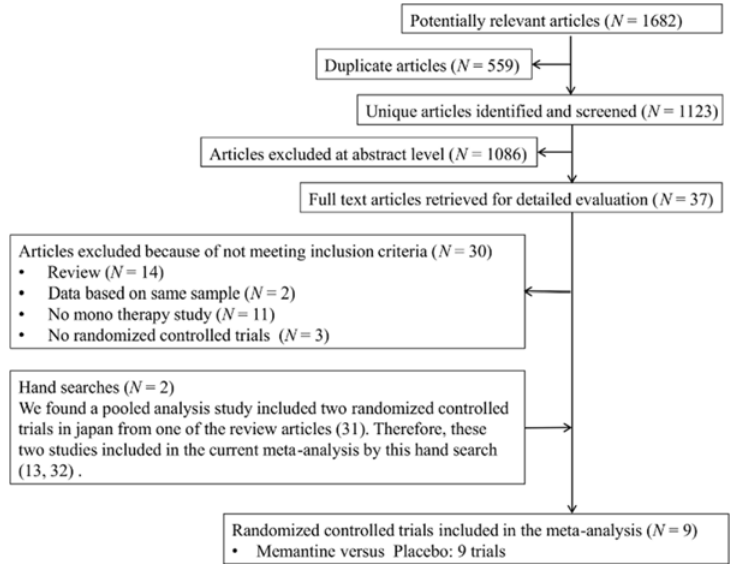
Fig 1. Preferred Reporting Items for Systematic reviews and Meta-Analysis (PRISMA) flow